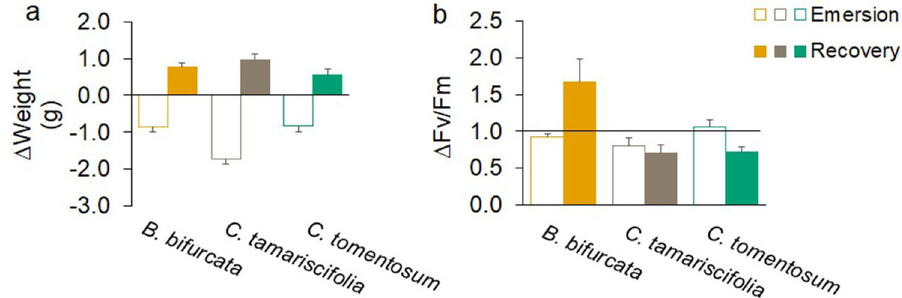
Figure 1. Mean (+ SE) value of ( a ) Δ weight, ( b ) Δ F v /F m after emersion and recovery in the field